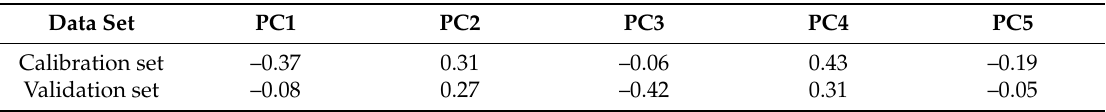
Table 2. Correlations ( r ) between SOM content and principal component analysis (PCA) in the calibration set and validation set.